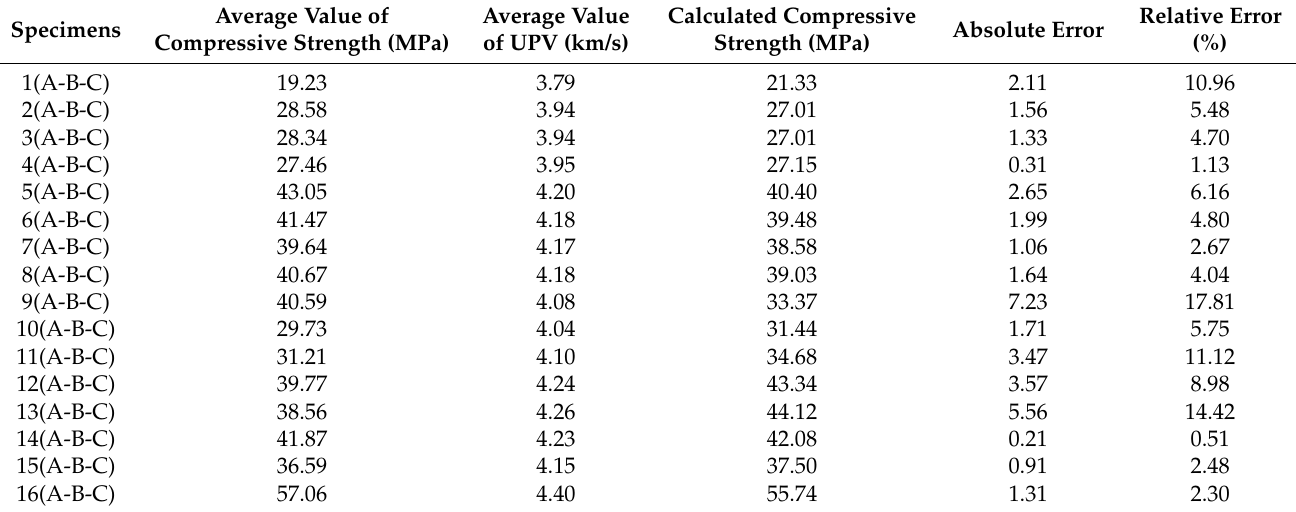
Table 3. Results obtained for the statistical analysis of exponential regression.